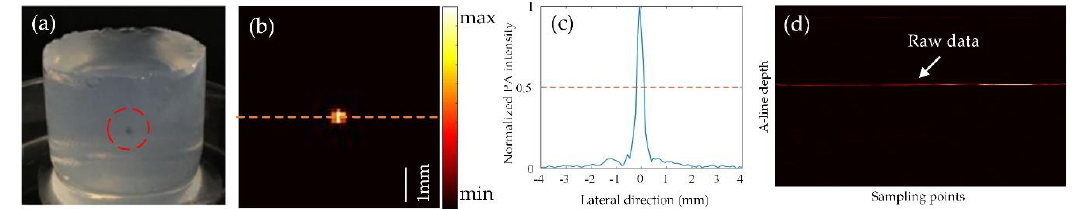
Figure 5. ( a ) Phantom of resolution test, ( b ) reconstructed PA image of target, ( c ) the profile along the dotted line in ( b ), and ( d ) raw data of a B-scan.